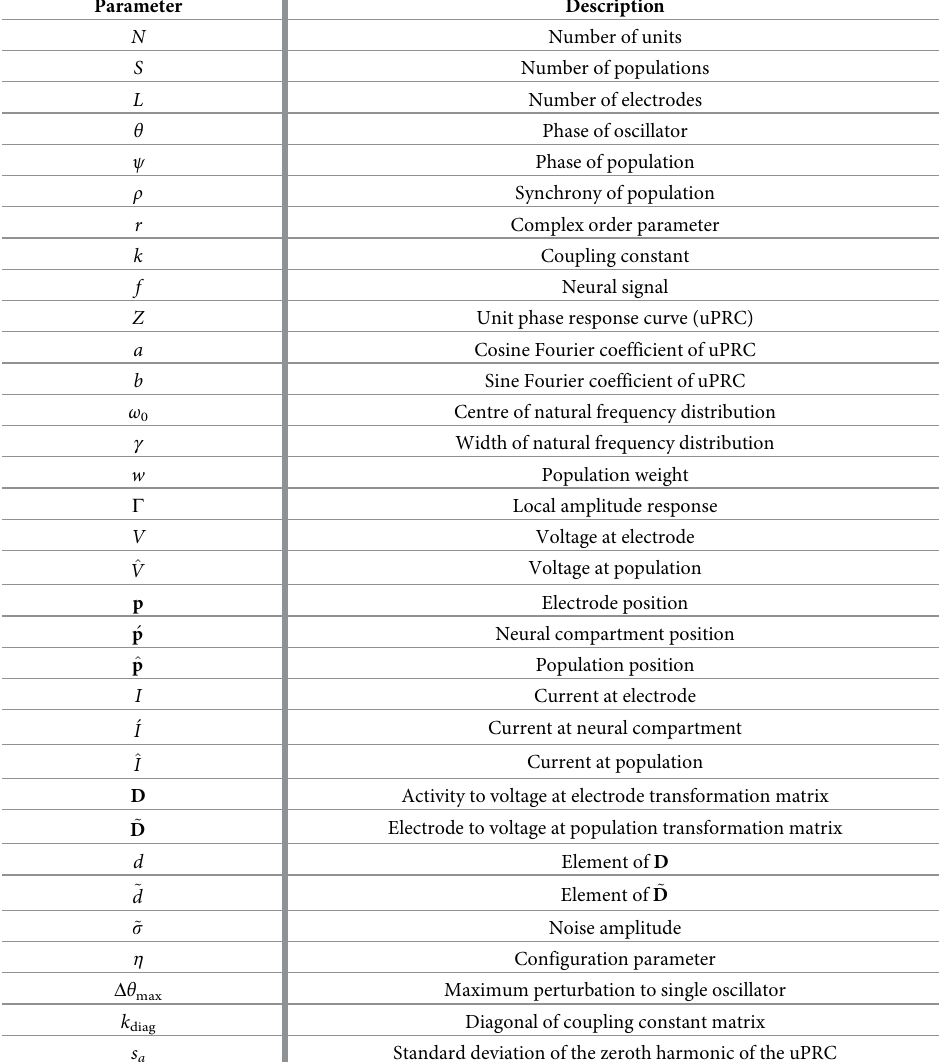
Table 1. List of frequently used symbols together with their